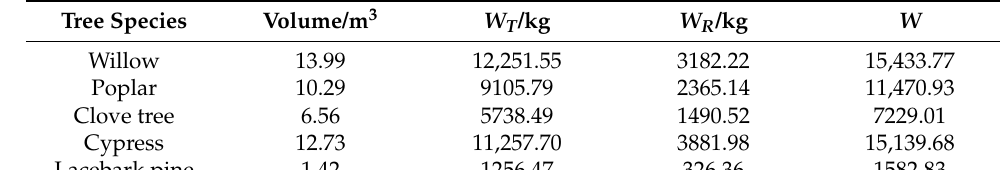
Table 7. Spectral angle classification results.